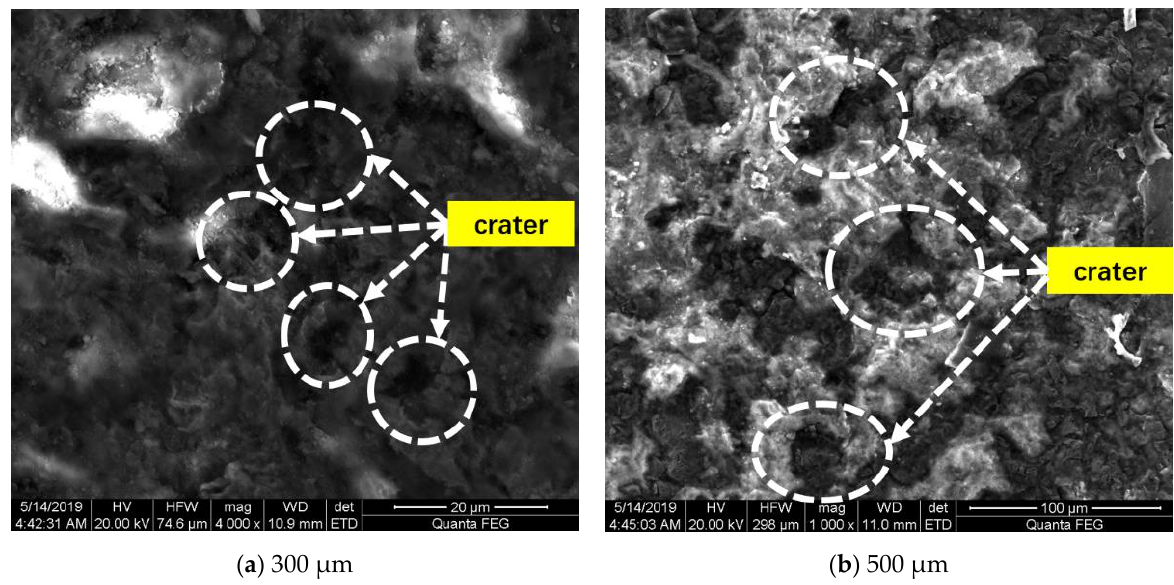
Figure 5. SEM images of erosion specimen surface exposed to different particle sizes. ( a ) The appearance of 300 μm particle impact specimen ( b ) The appearance of 500 μm particle impact specimen.